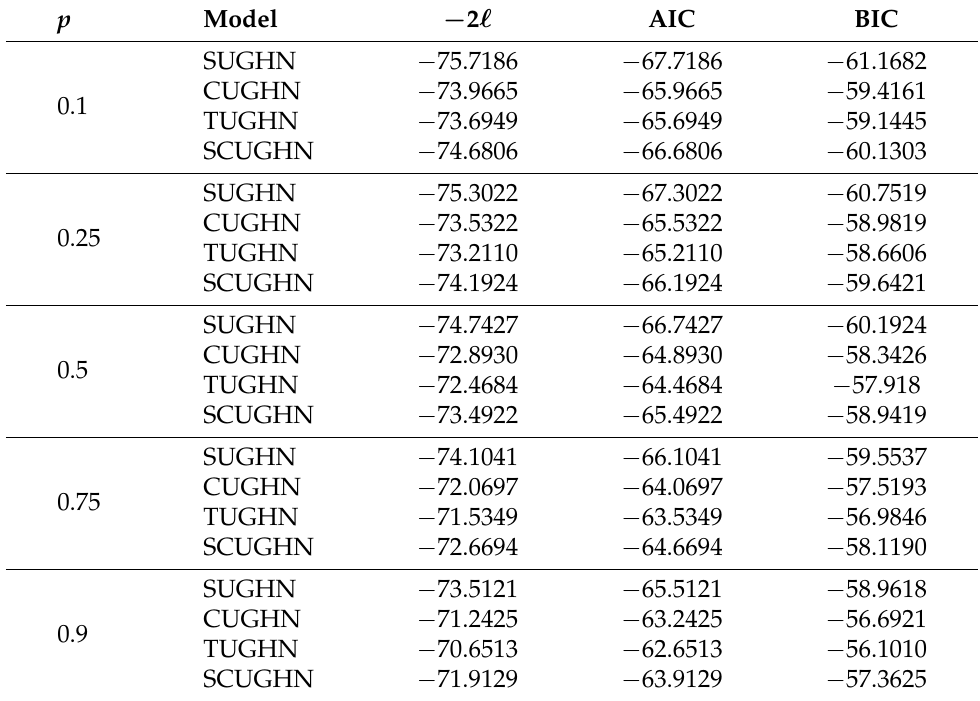
Table 4. Statistical